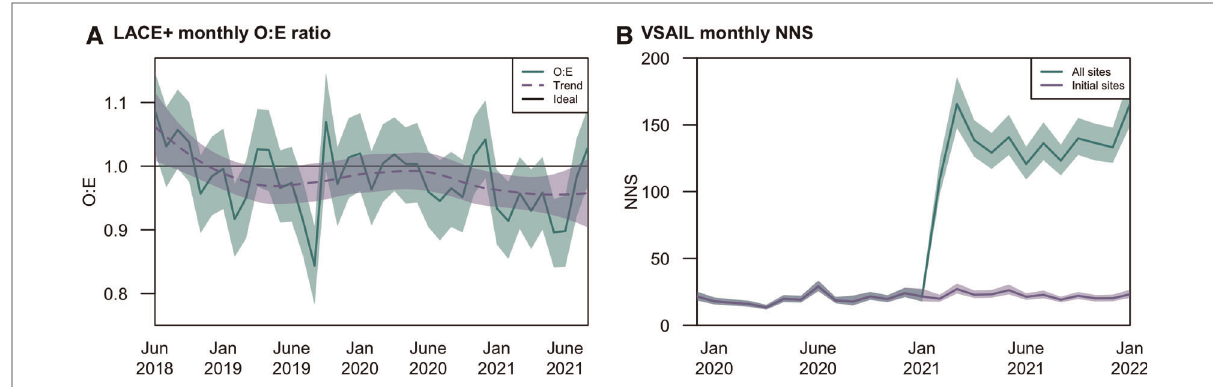
FIGURE 1 Temporal performance at Vanderbilt University Medical Center of the ( A ) LACE+ readmission model in terms of mean calibration (O:E); and ( B ) VSAIL suicidality model in terms of number needed to screen